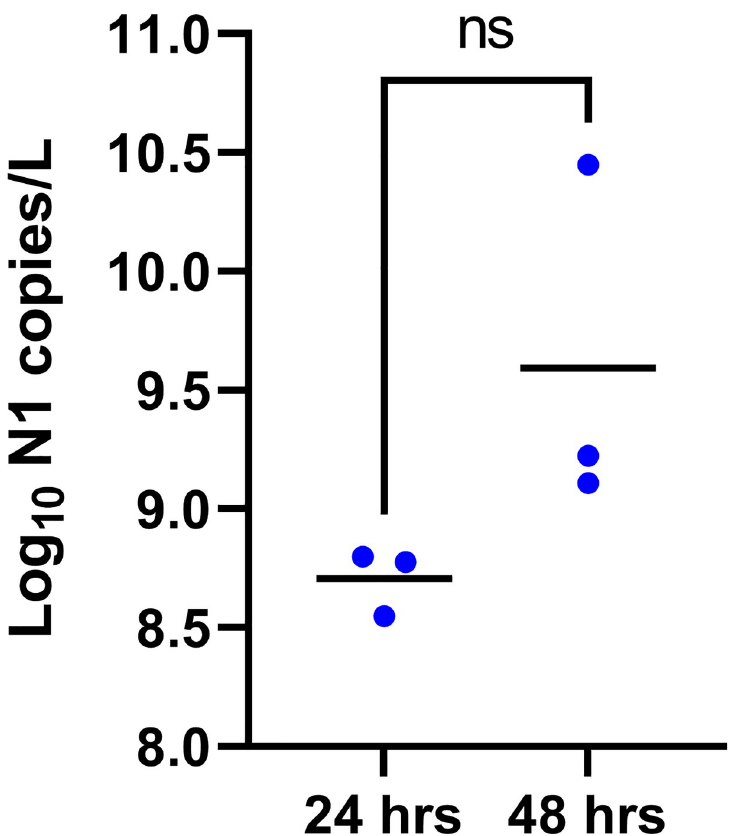
Fig 3. Effect of storage at 4˚C in PEG/NaCl: Following initial processing (pasteurization, preliminary centrifugation, and filtering), 24-hr composite samples from 3 different wastewater treatment plants were stored at 4˚C in a PEG/NaCl solution for precipitation and concentration of virions. Each point is the mean of two technical replicate measurements from a 24-hour composite sample. Horizontal black lines show means. See Fig 2 legend for explanation of pairwise